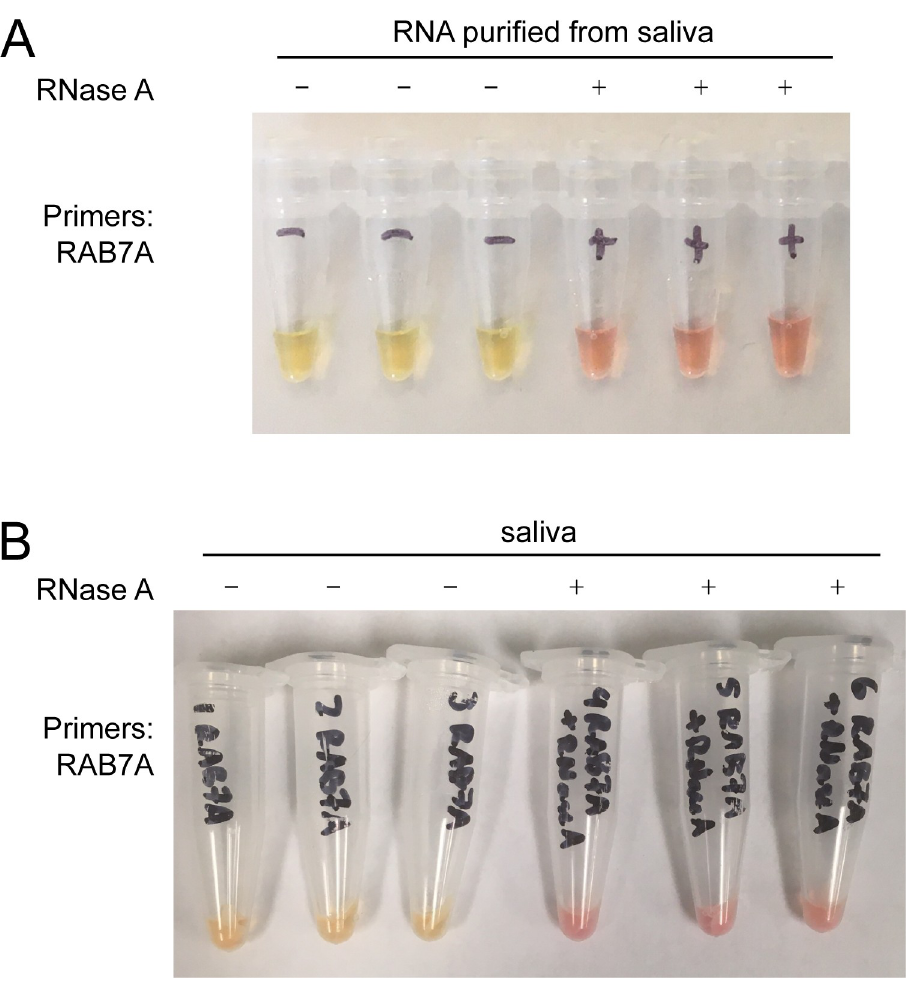
Fig 4. Detection of RAB7A RNA in saliva. A . LAMP reactions using RAB7A LAMP primers with purified RNA from healthy saliva (tubes 1–3), or purified RNA treated with RNase A (tubes 4–6). B . LAMP reactions using WHotLAMP detecting RAB7A in saliva (tubes 1–3), or with RNase A treatment (tubes 4–6).